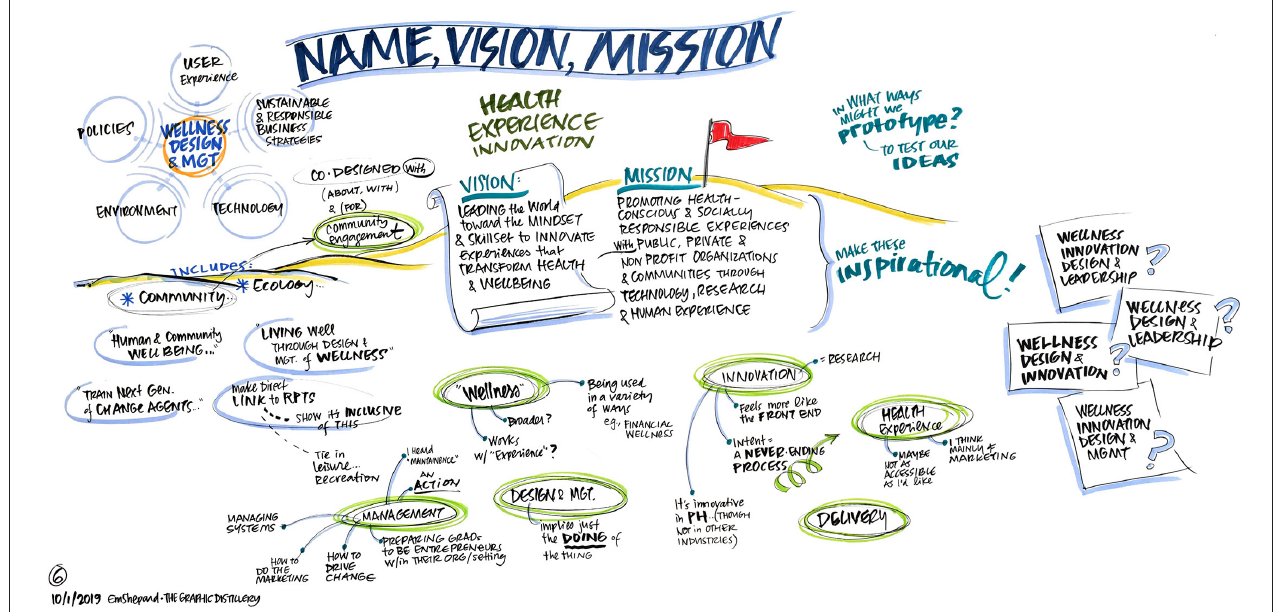
FIGURE 1 | What do the vision, mission, and name of this department look like?